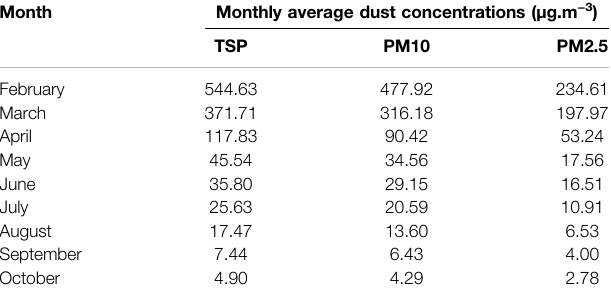
TABLE 1 | The monthly average dust concentrations in the Mogao